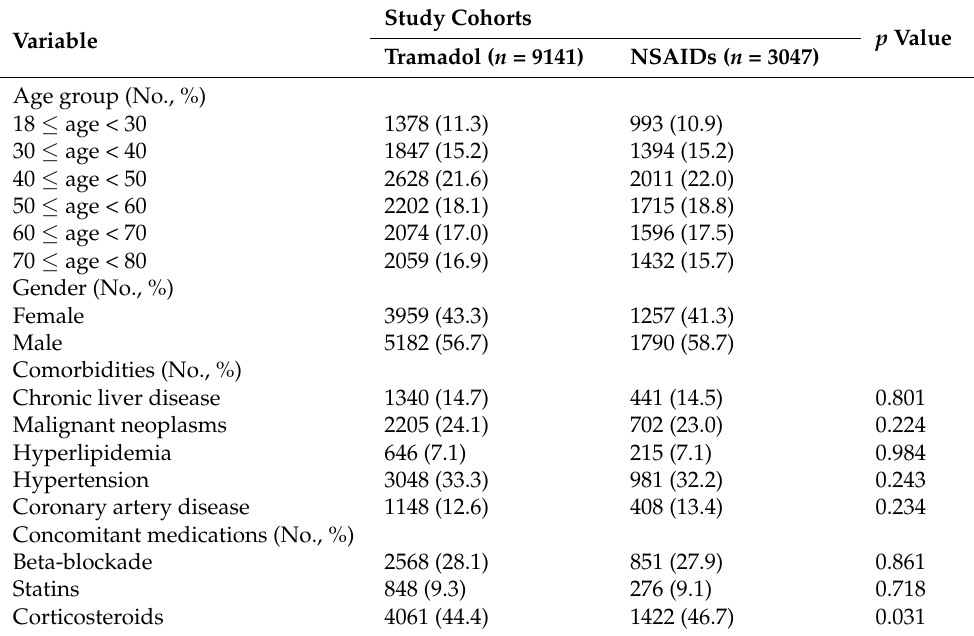
Table 1. Baseline characteristics of study cohorts.